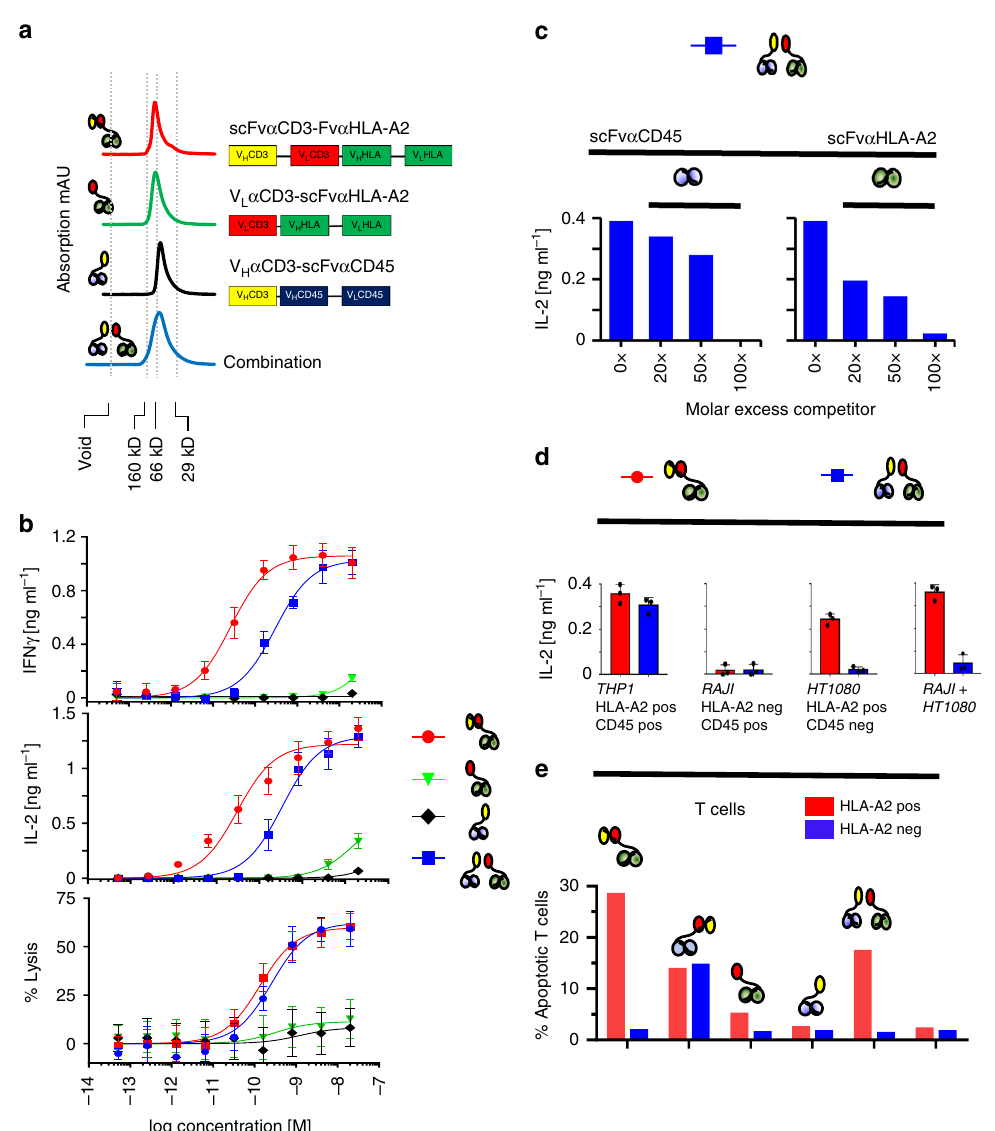
Fig. 2 Dual antigen-restricted reconstitution of a functional CD3-binding site. a V L α CD3-scFv α HLA-A2 (green curve) and V H α CD3-scFv α CD45 (black curve) hemibodies were isolated by immobilized metal ion af fi nity chromatography (IMAC) and size-exclusion chromatography (SEC) and analyzed by FPLC at 1 mg/ml. V0 void volume/aggregates. Typical elution pro fi les of the hemibodies, the bispeci fi c BiTE construct (scFv α CD3-Fv α HLA-A2, red curve on top), and a mixture of the two hemibodies (blue curve, bottom) are shown for comparison. b HLA-A2/CD45 dual-positive THP-1 acute myeloid leukemia cells were co-incubated with HLA-A2-negative donor peripheral blood mononuclear cells (PBMCs) and constructs as indicated. T cell engagement was assessed by interferon- γ (IFN- γ ) and interleukin-2 (IL-2) secretion and target cell lysis. The bispeci fi c HLA-A2 × CD3 BiTE was used as a positive control. Data represent the mean values with standard deviations (±SD) from triplicate wells from three independent experiments; the effector to target cell ratio (E:T) was 5:1. c Binding of hemibodies (6 nM each) to THP-1 cells was competitively blocked by molar excess of scFv speci fi c for CD45 (left) or HLA-A2 (right). Stimulation of donor PBMCs was assessed by IL-2 secretion at E:T = 2:1. Data represent the mean from two replicate wells from three experiments that yielded similar results. d Dual antigen-positive THP-1 leukemia, single-positve RAJI Burkitt lymphoma, or HT1080 fi brosarcoma cells were loaded with the hemibody pair (blue bars) or BiTEs (red bars), washed twice, and incubated with donor PBMCs as indicated at a E:T of 2:1. Secretion of IL-2 was assessed by ELISA. Data represent the mean (±SD) from two replicate wells from three experiments. e HLA-A2-positive (red bars) and HLA- A2-negative (blue bars) PBMNC were incubated with constructs as indicated (10 nM each). % apoptosis was assessed after annexinV staining by fl ow cytometry techniques as a measure of fratricide reaction. Data are representative for three independent experiments yielding comparable their target antigens in order to reconstitute the T cell triggering anti-CD3-binding site. Self-assembly of a functional CD3-binding unit after binding of only one hemibody, followed by side-to-side association of its partner independently of binding to the same cell surface, was therefore ruled out.